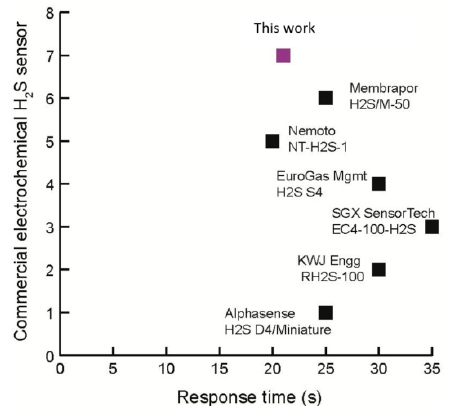
Figure 6. Response times of several commercial amperometric H 2 S sensors. The graph shows that the integrated sensor has a better response time compared to commercial